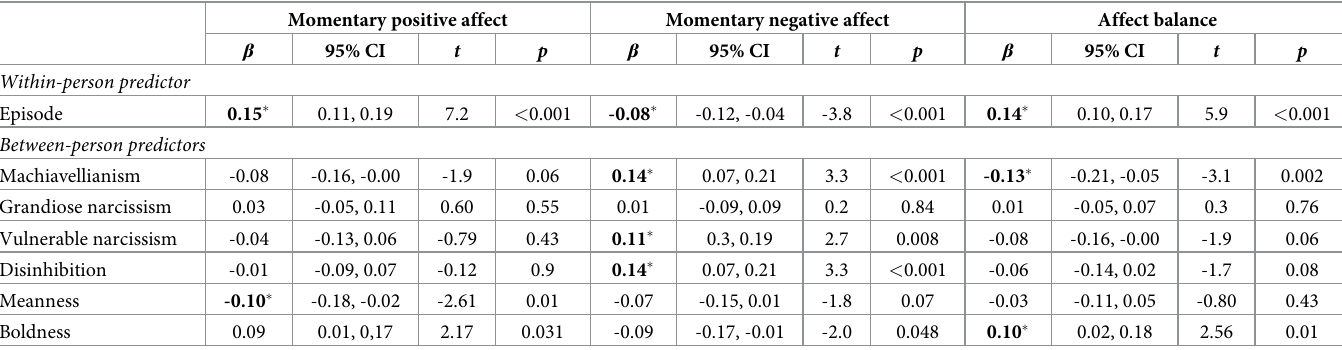
Table 3. Multilevel models predicting momentary affect from the Dark Triad traits.